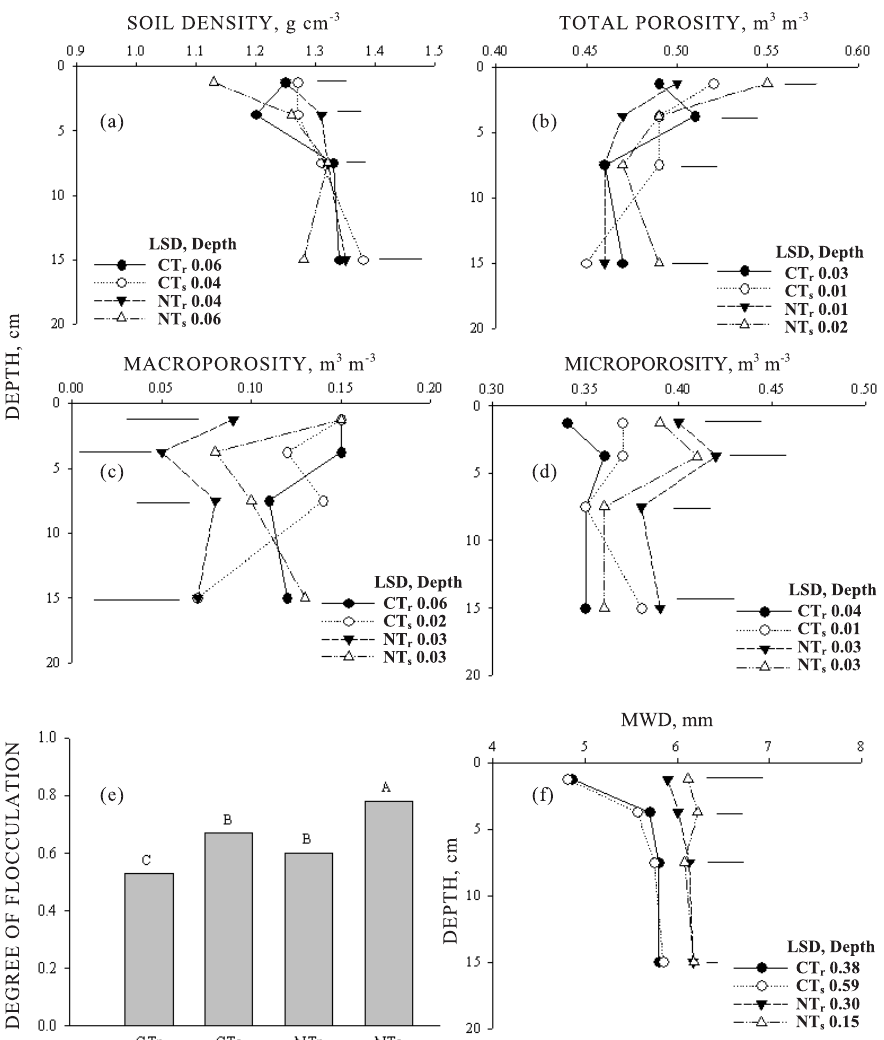
Figure 1. Soil density (a), total porosity (b), macroporosity (c), microporosity (d), degree of flocculation (e) and mean weighted diameter of aggregates (f) under conventional tillage (CT) and no-tillage (NT) and in cultivation systems with rotation (r) and succession (s) of crops, on a Humic Cambisol, Lages, 2008. Horizontal bars indicate least significant differences between treatments at the same depth, based on the t test; letters indicate differences between mean layers by the t test (p < 0.05). n = 64